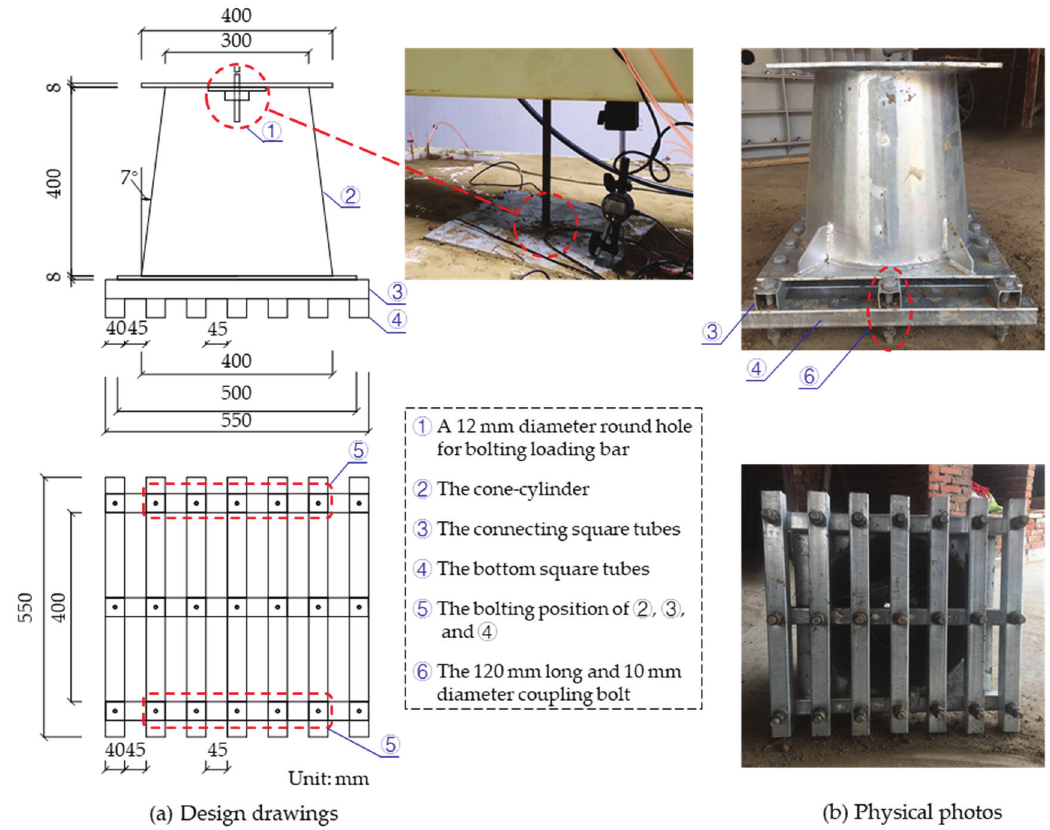
Figure 2. Design drawings and physical drawings of test foundation.